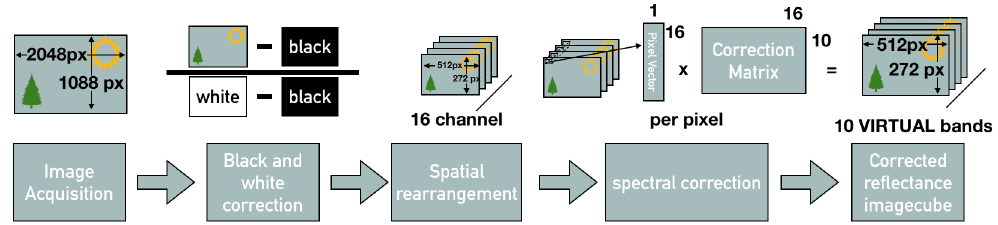
Figure 7. Overview of the processing chain: Image acquisition of the full frame image with the spatial spectral mosaic, full frame black and ’white’ correction, spatial rearrangement of the channels, spectral correction resulting in the reflectance image